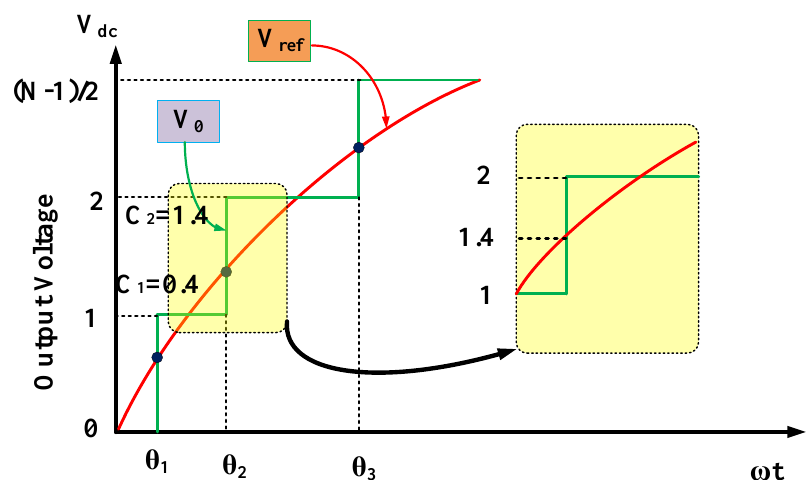
Figure 6. Level generation method of the optimized nearest level control.